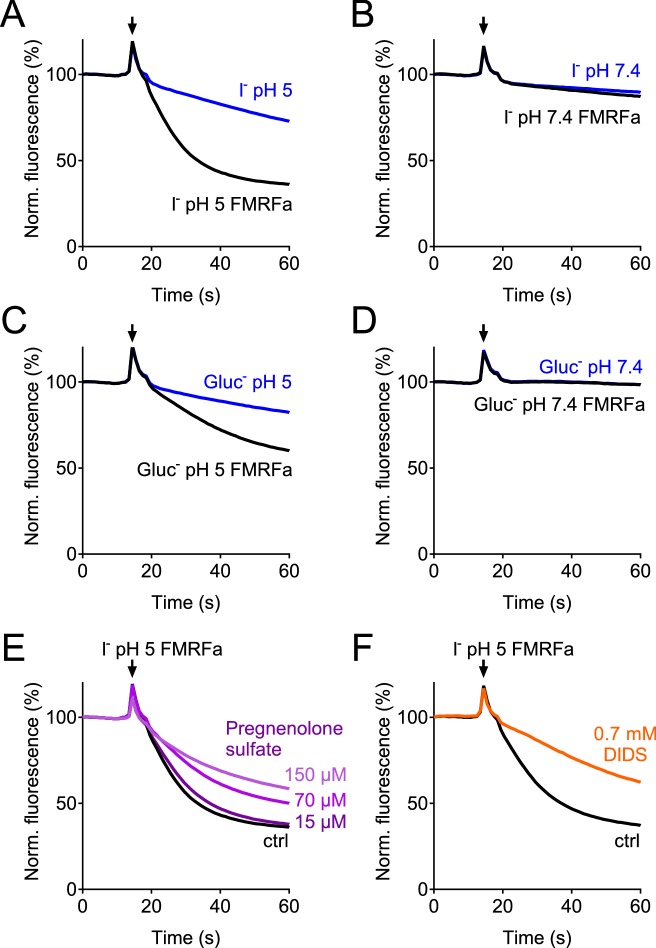
Verification of the assay for the genome-wide siRNA screen.(A–D) Controls in which E2GFP-2A-FaNaC-expressing cells were subjected to solutions containing I- (A, B) or gluconate (C, D) at pH 5 (A, C) or pH 7.4 (B, D). Only depolarization induced by activation of FaNaC by FMRFamide in the presence of I- and acidic pH (A) produced rapid quenching of E2GFP fluorescence. (E–F) ASOR inhibitors pregnenolone sulfate (PS, (E) and DIDS (F) inhibited fluorescence quenching. PS was added acutely together with the acidic solution. Cells were preincubated with DIDS, which induced a large increase in the absolute signal due to its intrinsic fluorescence.